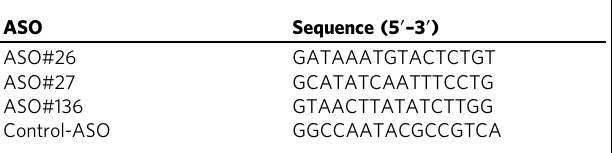
Table 1 Antisense oligonucleotide sequences. ASO Sequence (5 ′ – 3 ′ ) ASO#26 GATAAATGTACTCTGT ASO#27 GTAACTTATATCTTGG Control-ASO GGCCAATACGCCGTCA The sequences of the antisense oligonucleotides used for the in vivo